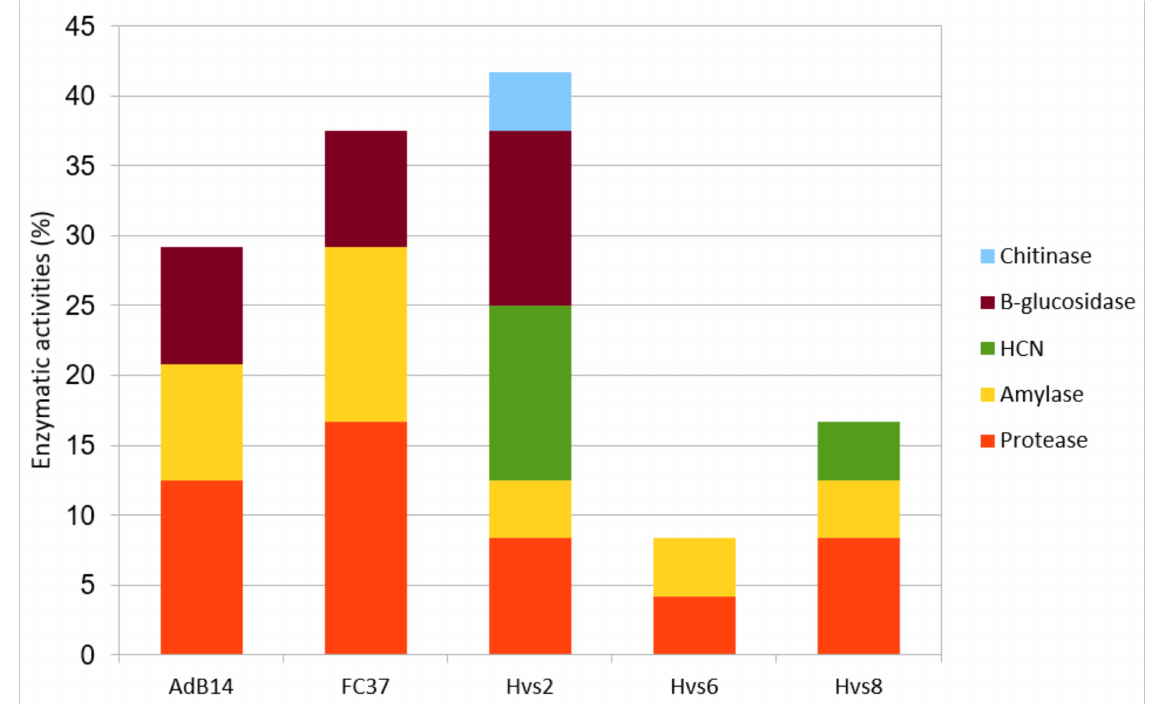
Figure 3. Percentage of biocontrol enzymatic activities displayed by strains Adb14, FC37, Hvs2, Hvs6, and Hvs8.